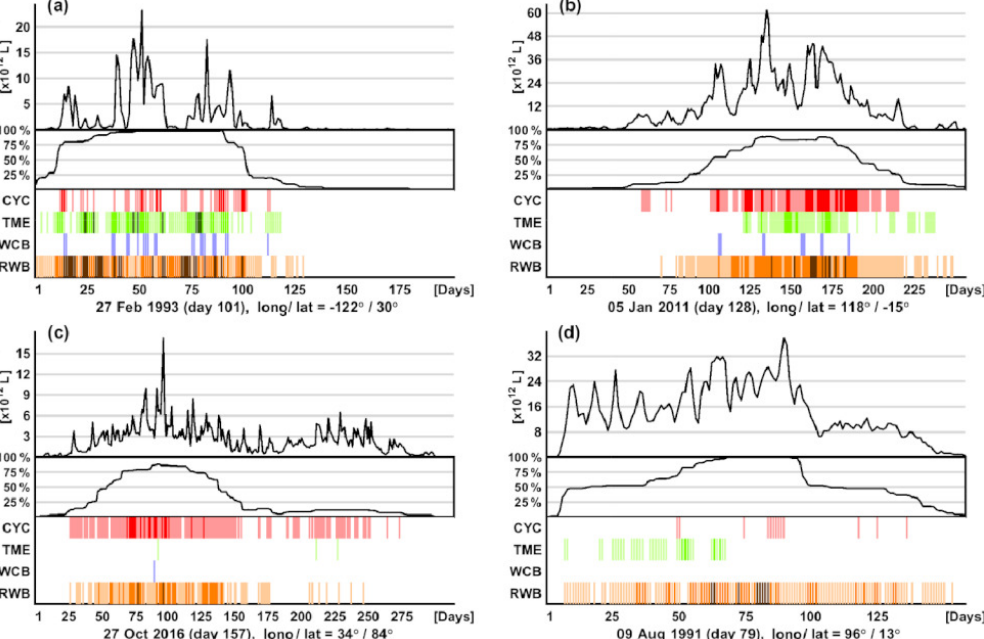
Figure 7. Panels (a–d) depict exemplary patches, with each label corresponding to the respective panel’s letter in Fig. 6. Time periods on the abscissa span from the earliest (day 1) to the latest date (e.g., day 170 in a ) of all extreme seasons of the grid points that compose each patch. The upper part of each panel shows time series of daily precipitation, accumulated for all grid points that compose the patch. Given that the patch period on the abscissa is composed by non-identical extreme seasons per grid point, the time series in the middle of each panel shows the fraction of the extreme season patch that includes the respective day. The lower part of the panel marks each day by a vertical line if a weather system overlapped with the patch (see text): red for cyclones, blue for WCBs, green for TMEs and brown for RWB. Central date and average latitude and longitude of each of the four patches are shown under the